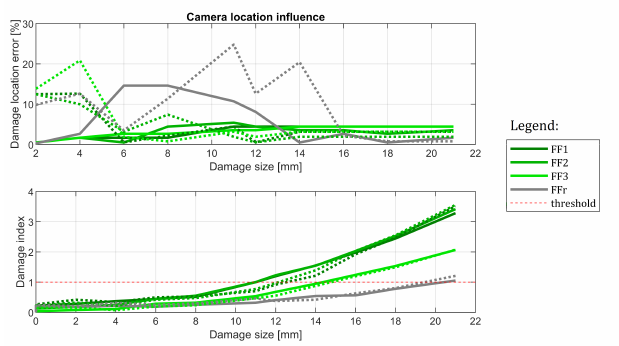
Figure 18. The results obtained for cases C#3 and C#4, that is for the same specimen and damage case, but with two different camera locations. Results from Camera 1 are marked in dashed lines.